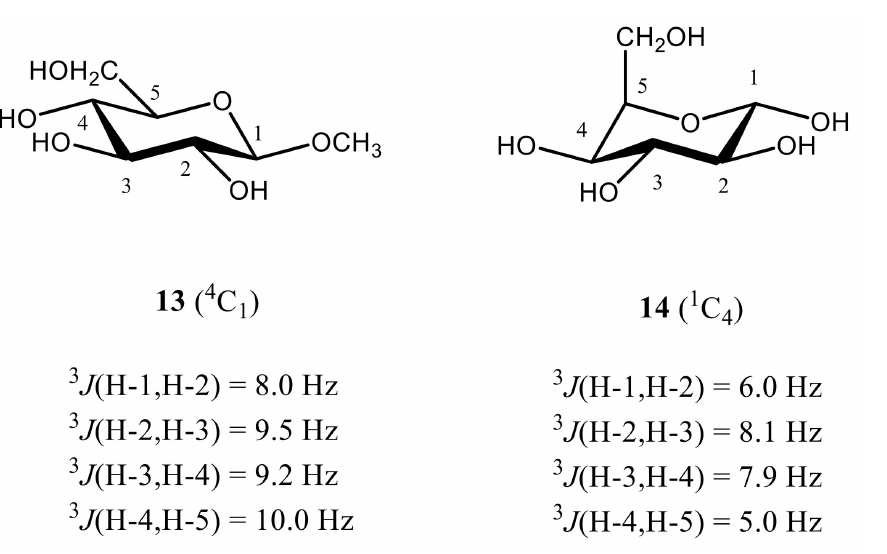
Figure 18. Most informative vicinal proton-proton spin-spin coupling constants in the representa- tive β -D-glucopyranoside ( 13 ) and α -D-idohexopyranose ( 14 ), providing accordingly, 4 C 1 and 1 C 4 conformations. Adopted from the review